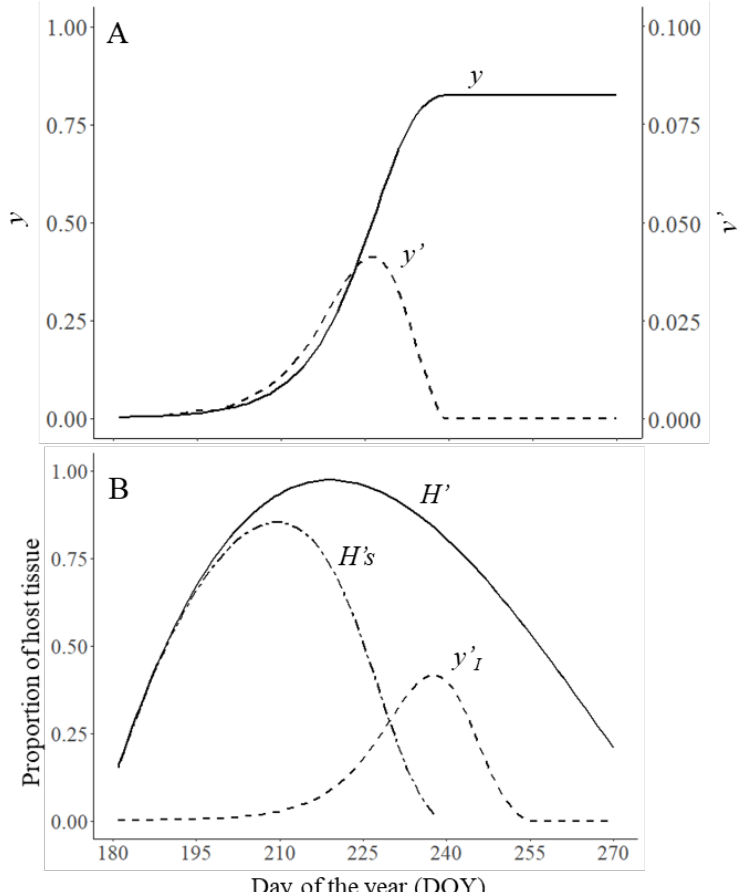
Figure 2. (A) Temporal dynamics of total ( y ) and relative ( y’ ) disease; ( B ) daily increase in the host tissue ( H’ ), tissue free from infection ( H’s ), and sporulating diseased tissue ( y’ I ). Values were